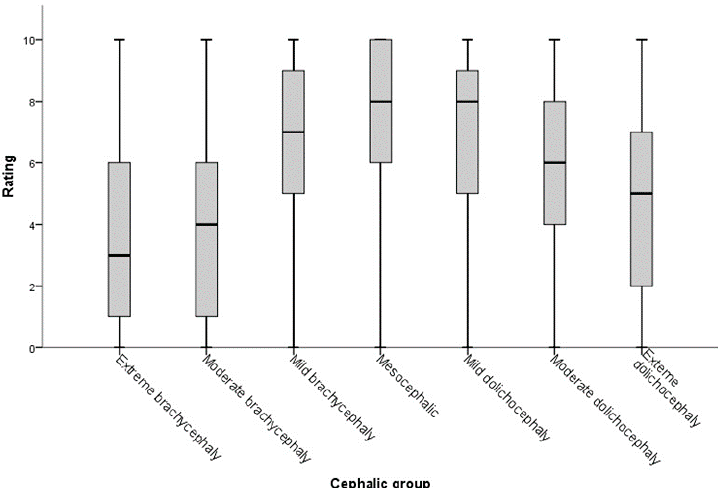
Figure 1. Preference ratings (0 = “I don’t like this cat at all”; 10 = “this is my favorite type of cat”) from 1239 cat owners for n = 15 cat images based on cephalic grouping, which was ascribed by expert ( n = 50) consensus (as per Table 1). Cephalic groupings range from extreme brachycephaly through to extreme